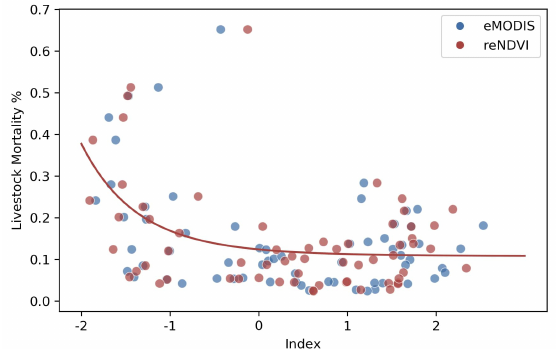
Figure 9. eMODIS and reNDVI index values compared to average livestock mortality percentage for